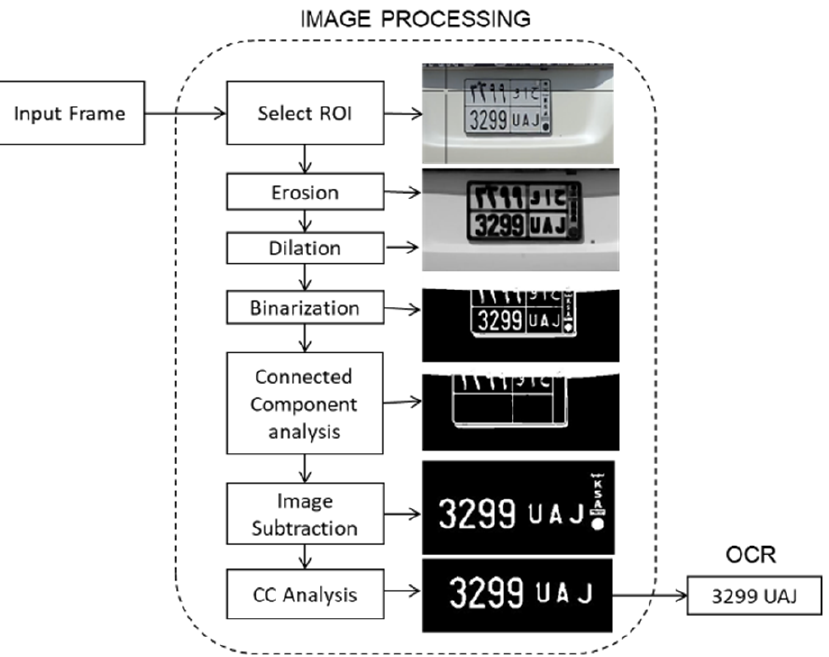
Figure 13. Morphological operations and OCR-based LP recognition pipeline.